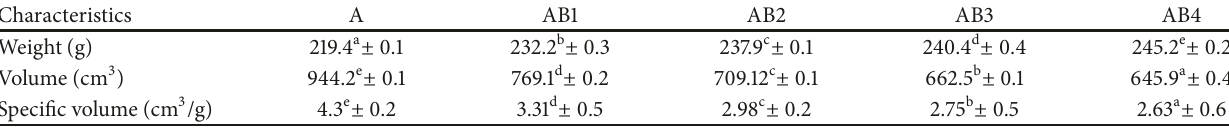
Table 4: Physical characteristic of wheat and walnut bread samples.